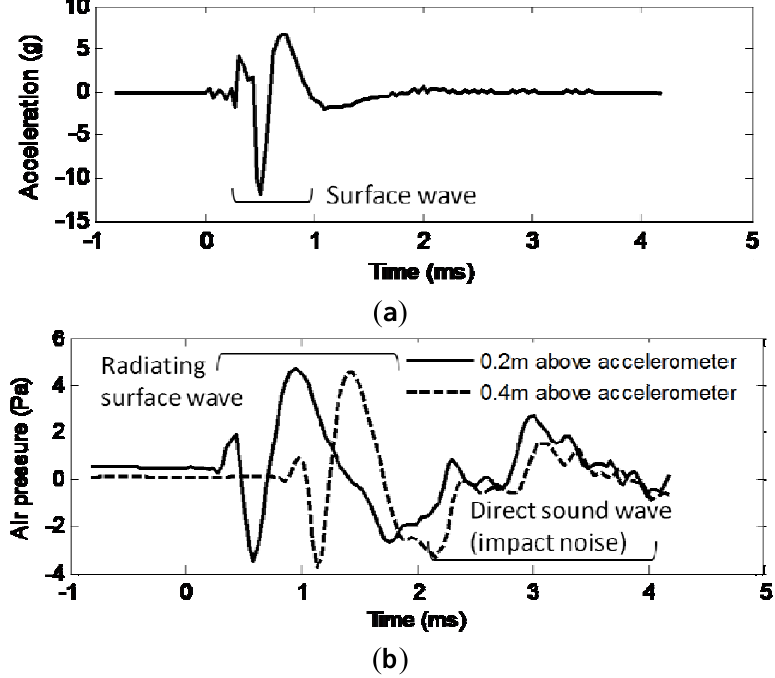
Figure 4. Comparison of microphone signal with accelerometer signal. ( a ) Measured surface acceleration. ( b ) Measured acoustic above surface